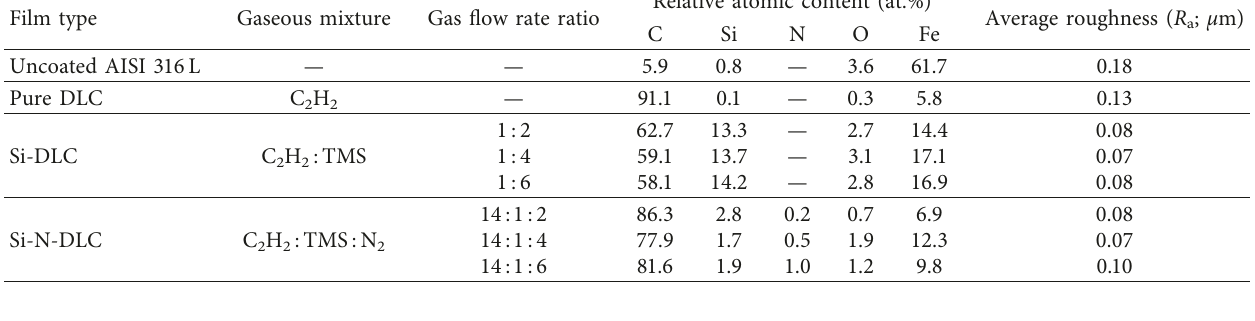
Table 3: Relative atomic content and average roughness of pure DLC, Si-DLC, and Si-N-DLC films. Film type